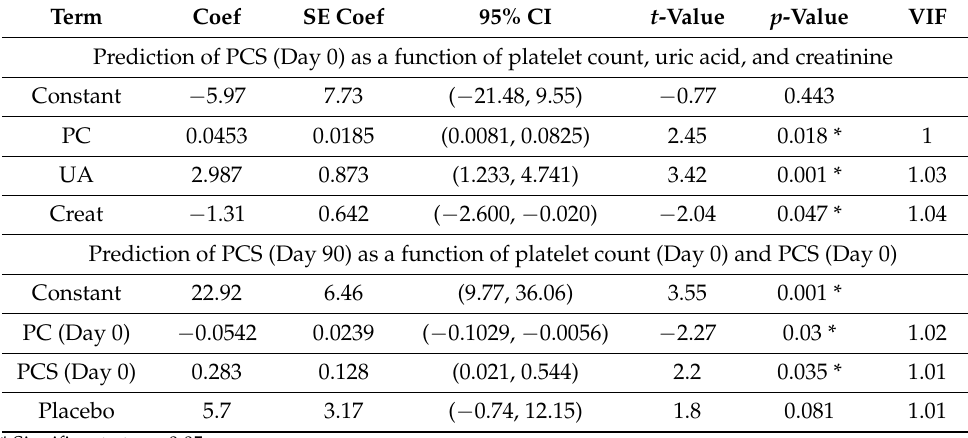
Table 8. Prediction of PCS (Day 0 and Day